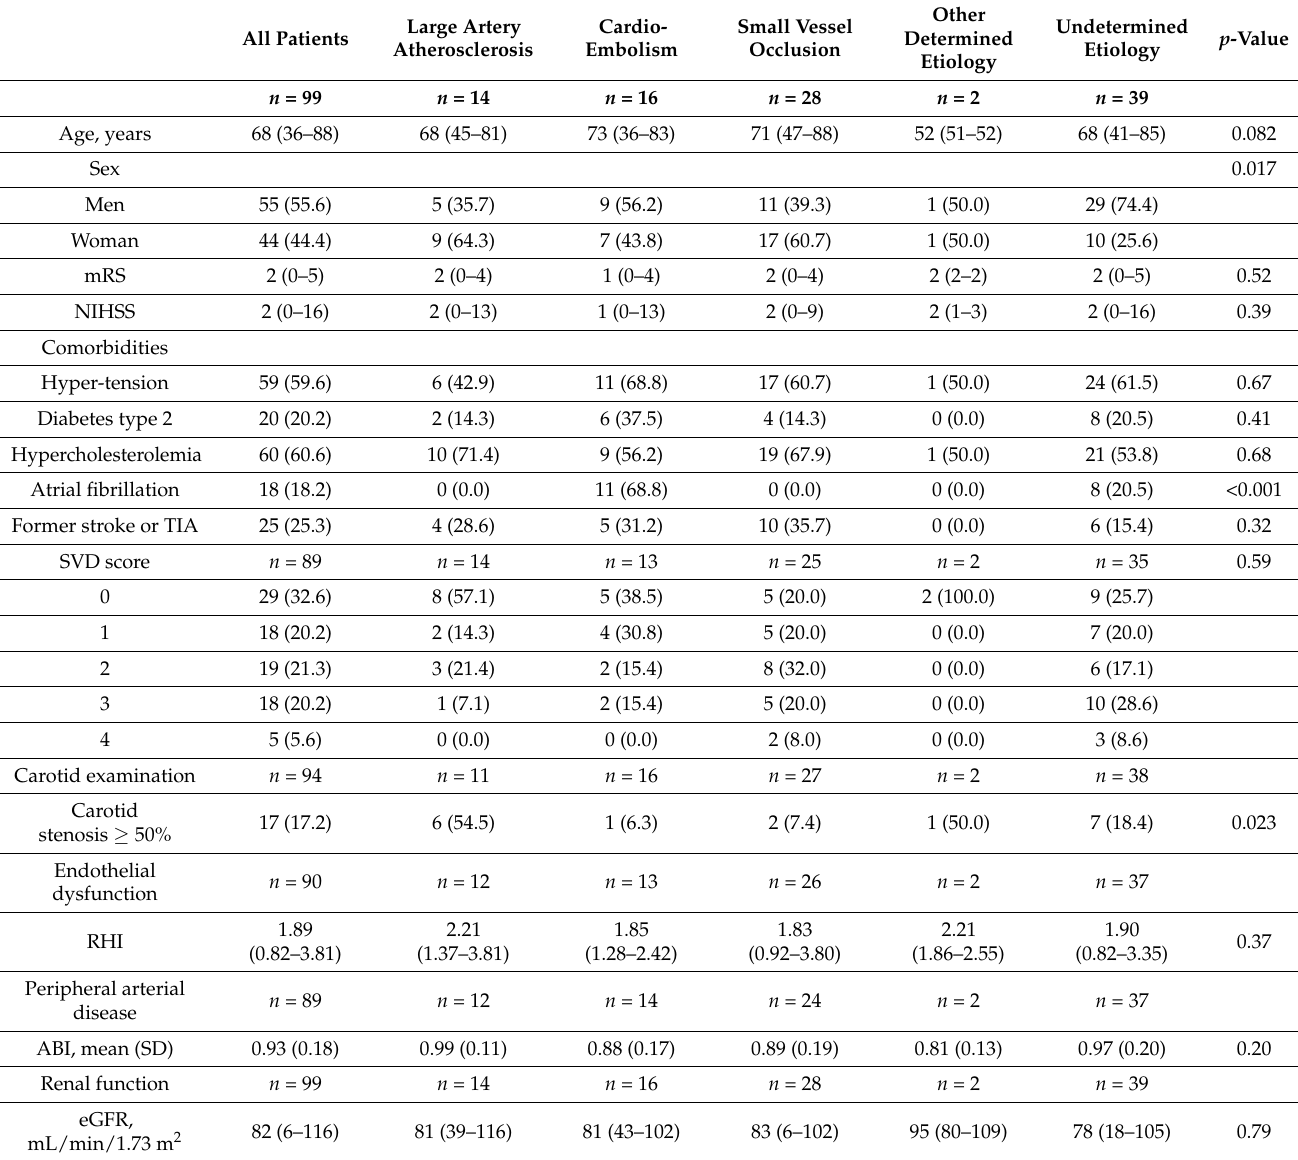
Table 1. Patient characteristics and vascular parameters for all patients and by TOAST